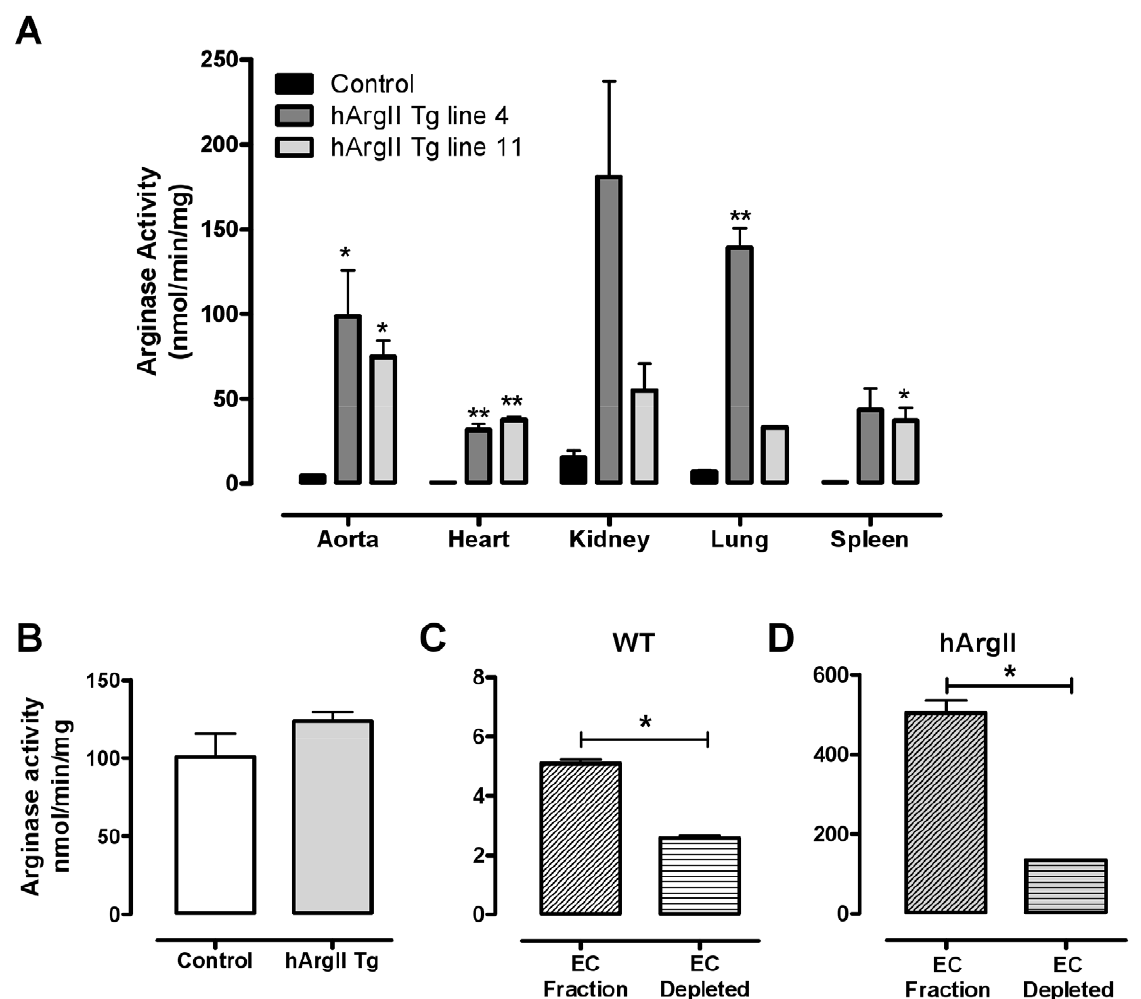
Figure 2. Arginase activities of: A heterozygous hArgII Line 4 and Line 11 mice and C57Bl/6 males (n=3 2 5) and B resident peritoneal macrophages. Macrophage activities are mean and range for two groups each of pooled samples for male and female homozygous hArgII mice and littermate controls (n=4/group for WT; n=4 or 5/group for hArgII lines 11 and 4, respectively). Arginase activity in extracts from lung endothelial cells immunomagnetically separated to endothelial cells (EC fraction) or fractions depleted of endothelial cells (EC depleted) from C C57Bl/6 (n=4) and D from hArgII Line 4 mice (n=4). Data are presented as mean 6 SEM. Values were compared A with a 1-way ANOVA with Bonferroni posthoc test and B – D with Student’s t-test where * = P , 0.05, ** = P , 0.01 and *** = P , 0.001. hArgII: 0.64 6 0.04; P . 0.05; n =6 2 11). Similarly, plasma lipid profiles were unaffected in the hArgII lines (data not shown). endothelial cell-enriched fractions isolated from hArgII transgenic animals had 3.7 6 0.3-fold higher arginase activity than fractions partially depleted of lung endothelial cells (P , 0.05; Fig. 2C & D). hArg II Overexpression Induces Endothelial Dysfunction Maximal contractile responses to high K + levels in aorta and small mesenteric arteries (SMA) from hArgII mice were not significantly different from their non-transgenic littermate controls (Table 2; n= 7 2 8; P . 0.05). Endothelial dysfunction was evident in aortas from hArgII mice, as demonstrated by a significant shift to the right in the endothelium-dependent vasodilator acetylcho- line (ACh)-induced relaxation (EC 50 : 7.1 6 0.2 M) compared to their non-transgenic littermate controls (EC 50 : 7.6 6 0.1 M; Fig. 3A, n= 5 2 8; P , 0.05). There was no significant difference in ACh-mediated relaxation in small mesenteric arteries (SMA) constricted with cirazoline (Fig. 3B) or with inhibition of endothelium-dependent hyperpolarizing factor (EDHF) with a high K + constriction (Fig. 3B; n= 4 2 7; P = 0.06), although the